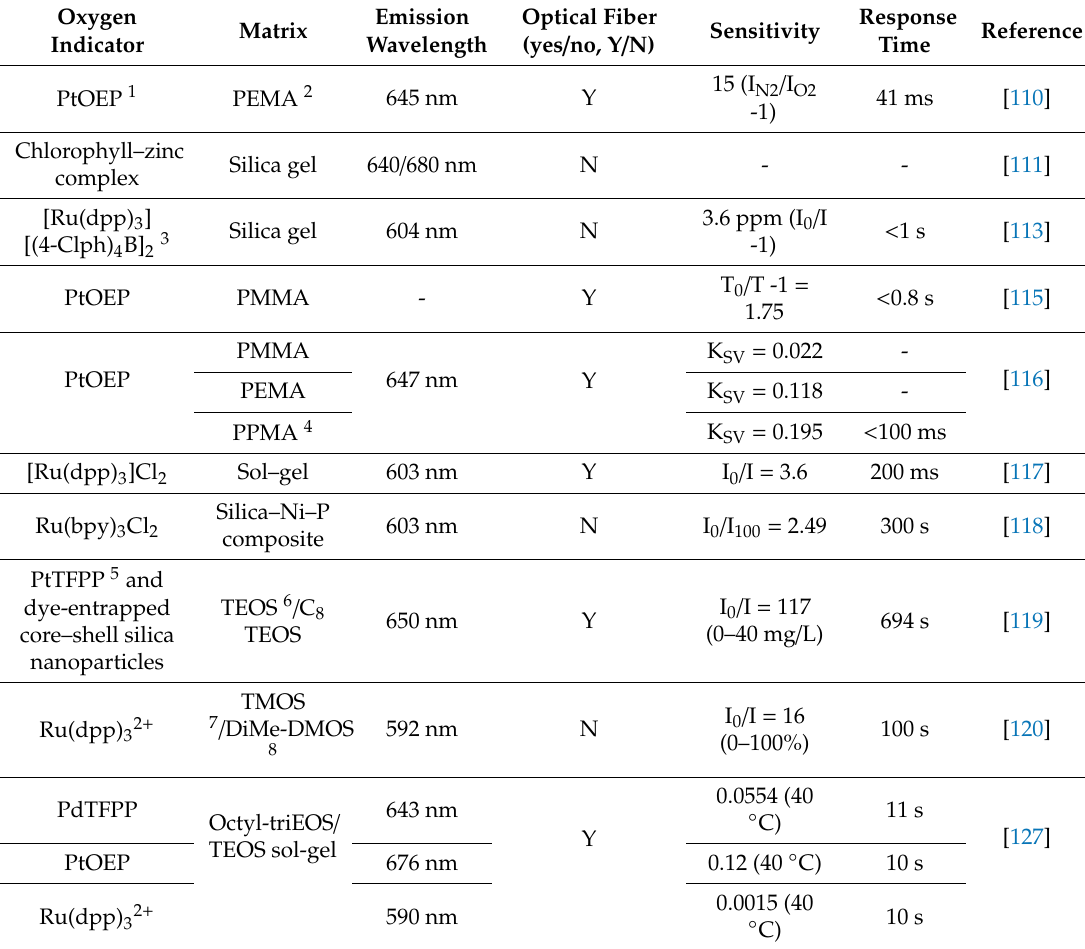
Table 3. Comparison of fluorescence quenching dissolved oxygen